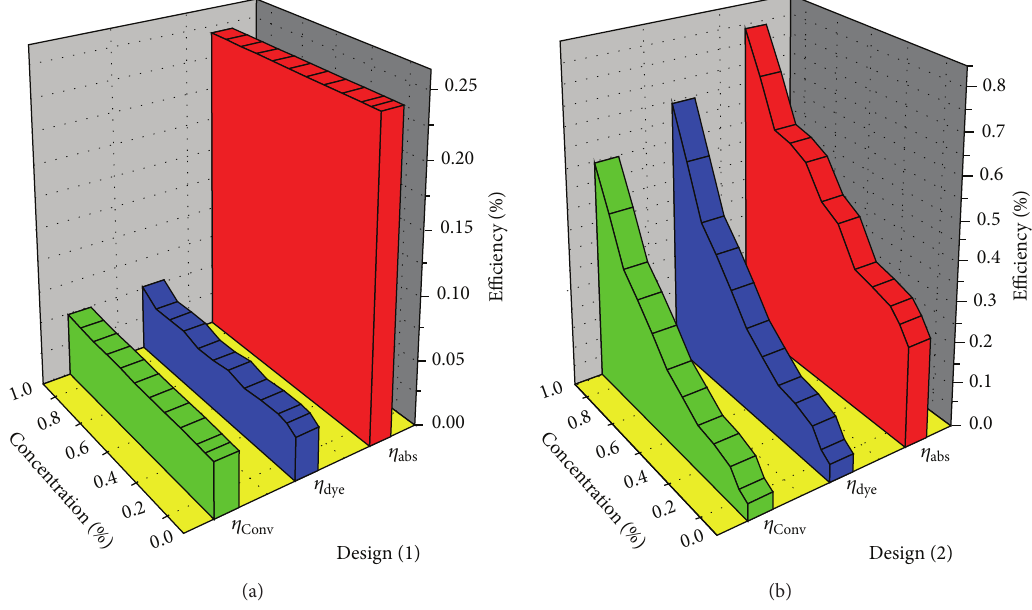
Figure 10: Effect of nanosilica concentration on the efficiency parameters of TLSC designs.